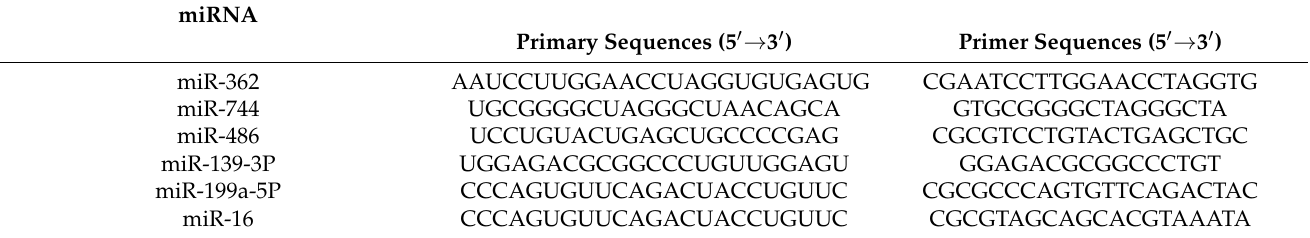
Table 1. Primer information.